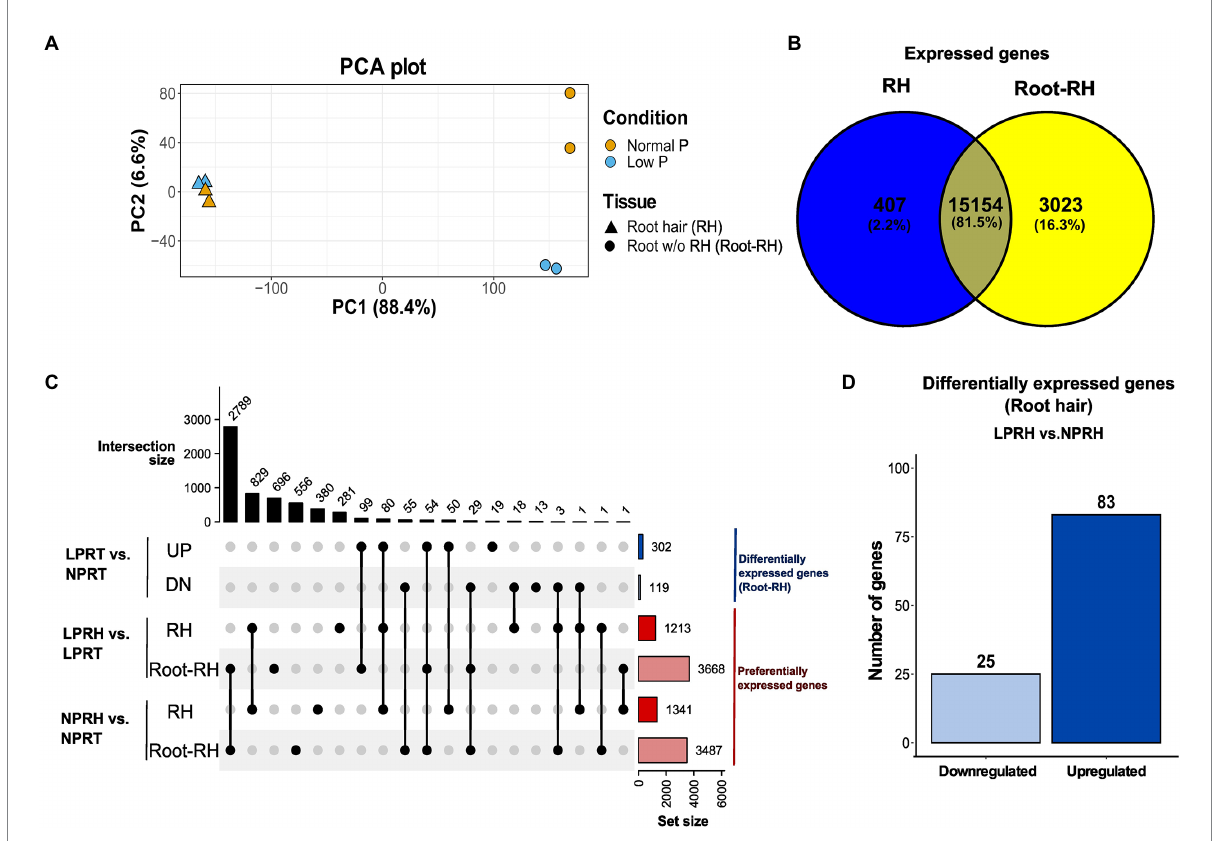
FIGURE 2 Summary of the RNA-seq results in root hairs (RH) and root without RH (Root-RH). (A) Principal component analysis (PCA) plot (PC1 vs. PC2) of all the samples in normal phosphorus (NP) and low phosphorus (LP) conditions. Triangle represents RH samples and the circle Root-RH samples. The yellow in PCA denotes NP, and the blue denotes LP conditions. Variation explained by each principal component is denoted in brackets. (B) Venn Diagram represents the comparison between the expressed active genes in RH (blue) and Root-RH (yellow) tissue in both conditions. (C) The comparisons are analyzed using an upset plot, denoting the intersection size on the upper left and set size on the lower right. Blue-colored sets represent differentially expressed genes in Root-RH between NP and LP conditions, and red-colored represent preferentially expressed genes in RH compared to Root-RH in each of the two conditions. (D) Bar graph showing differentially expressed genes in RH between NP and LP conditions. LPRH, low phosphorus root hair; LPRT, low phosphorus Root-RH; NPRH, normal phosphorus root hair; NPRT, normal phosphorus Root-RH; UP, upregulated; and DN,